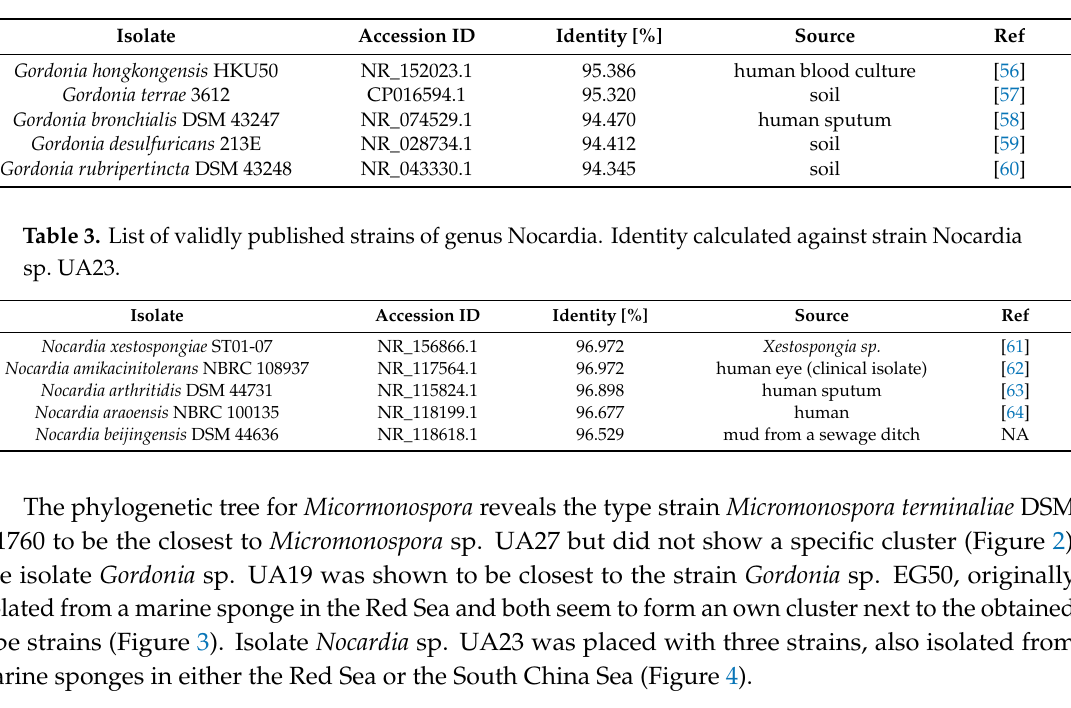
Table 2. List of validly published strains of genus Gordonia. Identity calculated against strain Gordonia sp. UA19.